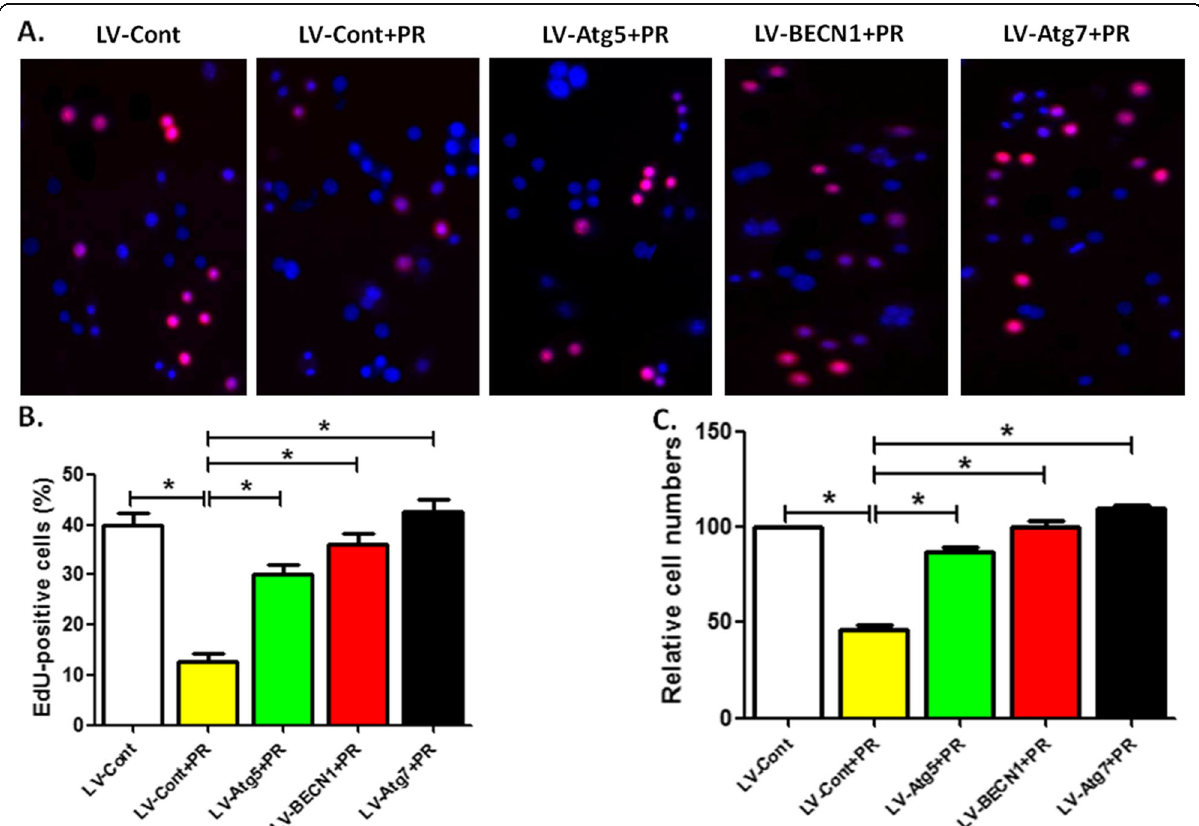
Fig. 2 Overexpression of autophagic gene reverses Puerarin-reduced OCP proliferation. a The proliferation of viruses-transduced OCPs treated with Puerarin (50 μ M) for 24 h was detected using EdU kit. Scale bar, 250 μ m. b Statistical diagram displayed the percentages of EdU-positive cells in A (50 cells per field, n = 10). c After treatment as described for ( a ), the OCP proliferation was measured using CCK-8 kit. The group without Puerarin were regarded as the control group (100%). Data are presented as mean ± SEM from three independent experiments. Compared between Group LV-Cont and Group LV-Cont+PR, Group LV-Cont+PR and Groups LV-Atg5/BECN1/Atg7+ PR, respectively, * P < 0.05. PR,